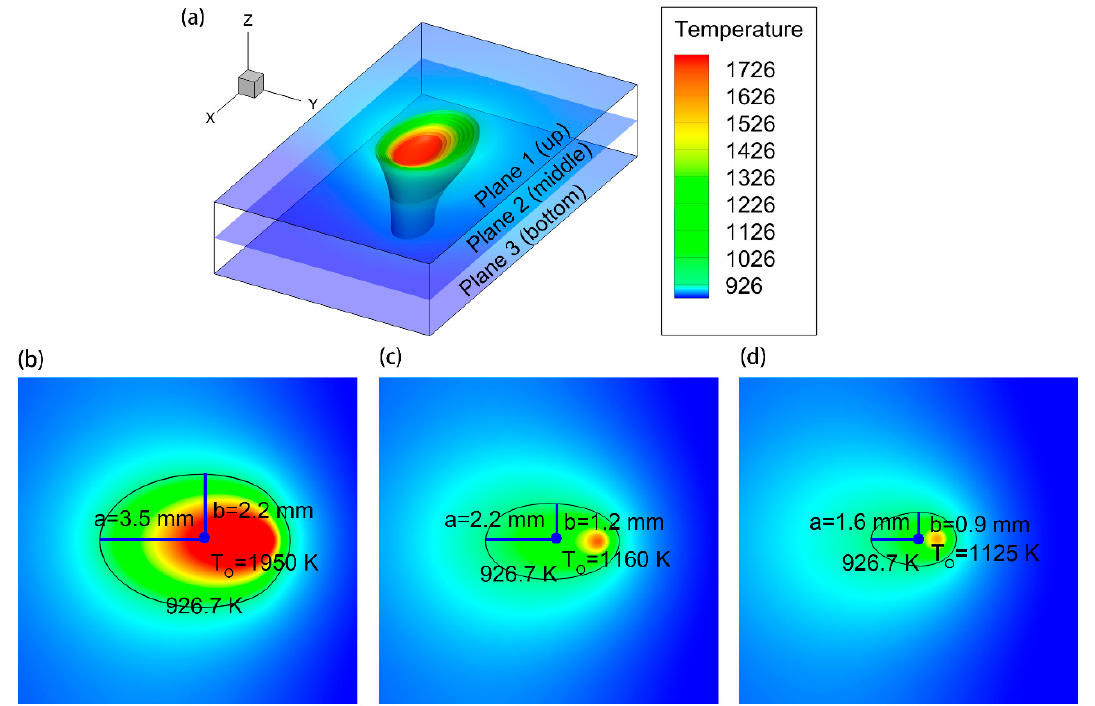
Figure 10. ( a ) Three-dimensional shape of the laser welding pool from heat transfer calculation; ( b ) temperature contour of plane 1; ( c ) temperature contour of plane 2; ( d ) temperature contour of plane 3. From ( b – d ), the parameters for calculating transient thermal conditions (Equations (3) and (4)) are obtained.